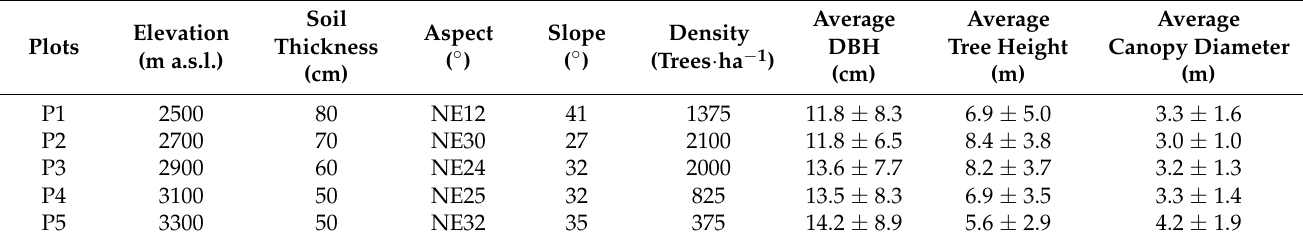
Table 1. Basic characteristics of the five Qinghai spruce plots (mean value ± standard deviation).